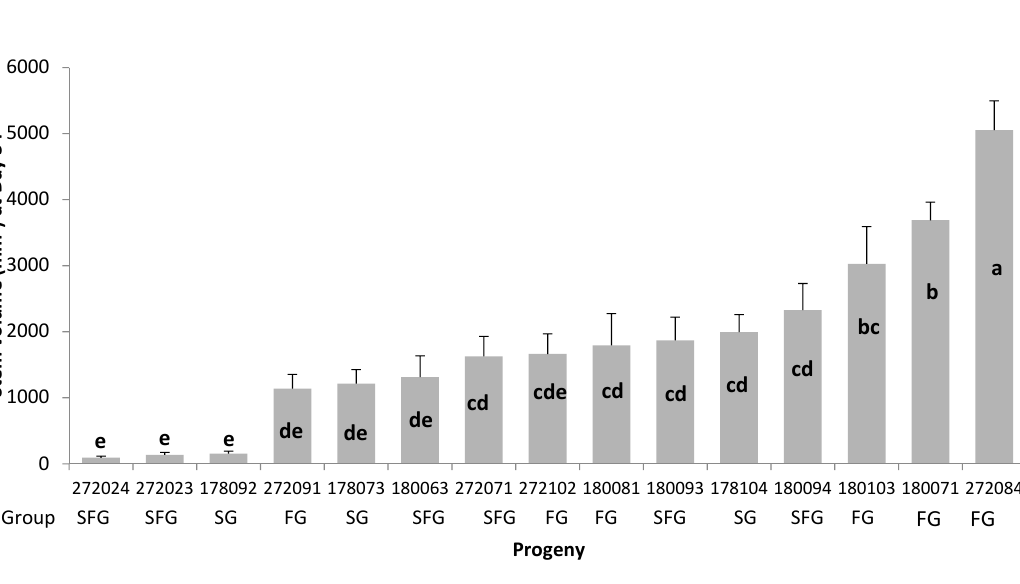
Figure 4. Mean stem volume (mm 3 ) (+ SE) of 15 selected balsam poplar progeny at Day 34 under near-optimal greenhouse conditions. Note: SG = slow-growing progeny; SFG = slow-growing progeny from a fast-growing family; and FG = fast-growing progeny. Significant differences between progeny means are indicated by different letters at p ≤ 0.05.